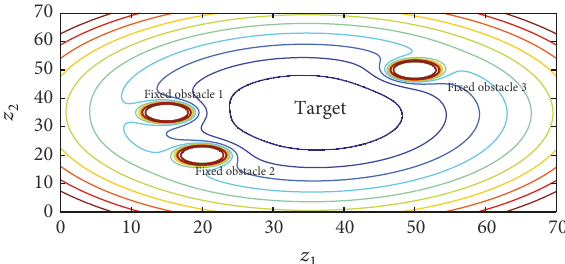
Figure 4: The contour plot of the total